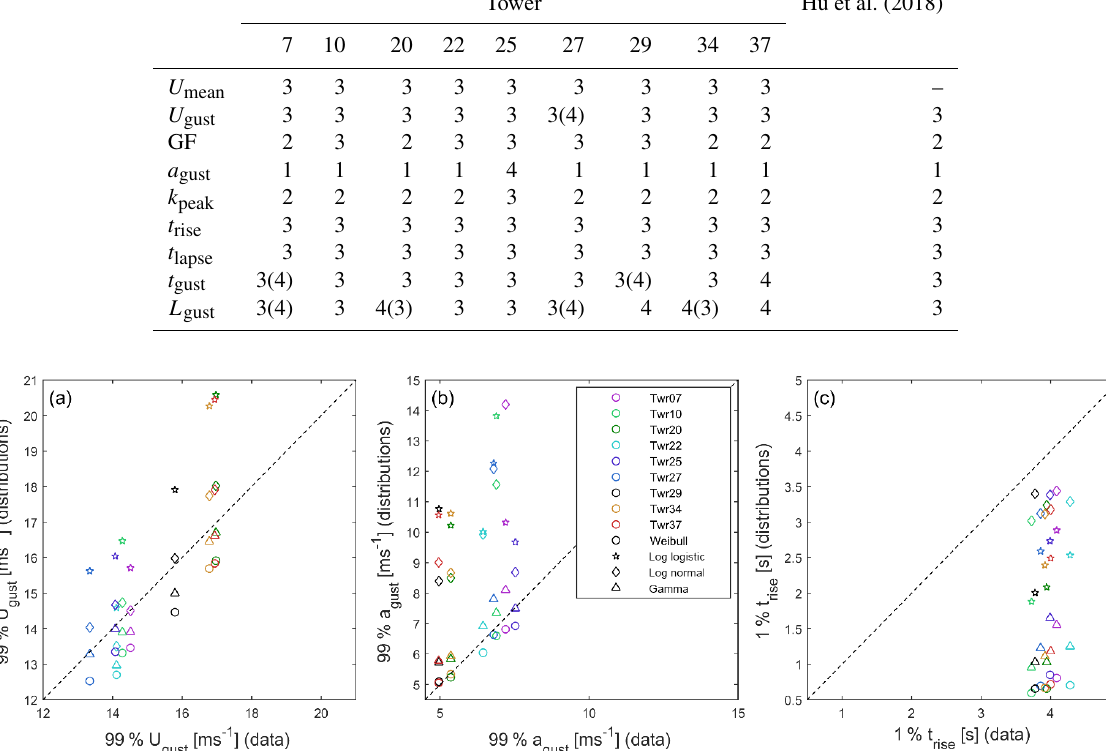
Table 2. Best-fit distribution types for each gust property (in each 10min period when U mean > 3ms − 1 ) for a measurement height of 60ma.g.l. at each tower. Also shown are results from moderately complex terrain (Hu et al., 2018). The distribution types are referred to as 1–4, where 1 is Weibull, 2 is log-logistic, 3 is lognormal, and 4 is gamma. Distribution types shown in parentheses represent an equivalently good fit (i.e., those with negative log likelihood of less than 0.1% lower than the best-fit distribution). Tower Hu et al. (2018)